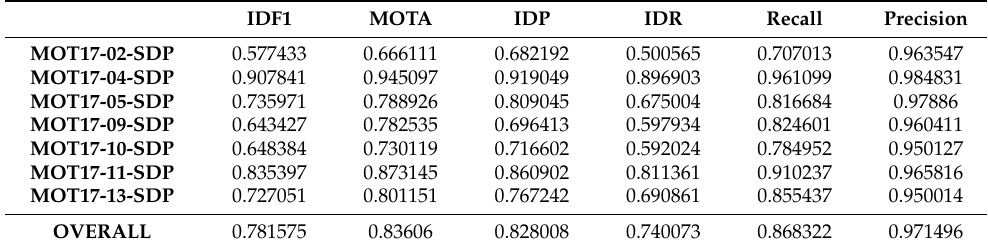
Table 1. MOTA values based on MOT17.